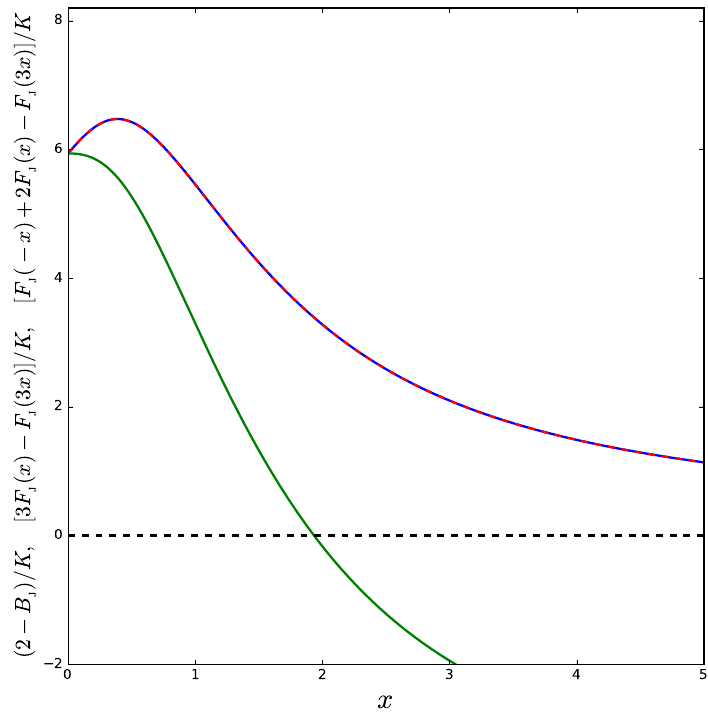
( t 1 , t 2 , t (cid:48) )] / K with t 1 = = 0 and t (cid:48) B , t (cid:48) 2 x , t 2 = x , t (cid:48) 2 1 1 J − − ( t 1 , t 2 ) appearing in the definition of B being given in (119). J J ( ( x ) ( 3 x )] / K . The two functions are identical and x ) + 2 F F J J J − − ( x ) ( 3 x )] / K , which is incorrectly interpreted as F J J − ( ( x ) ( 3 x ) , can be negative x ) + 2 F F J J J − −